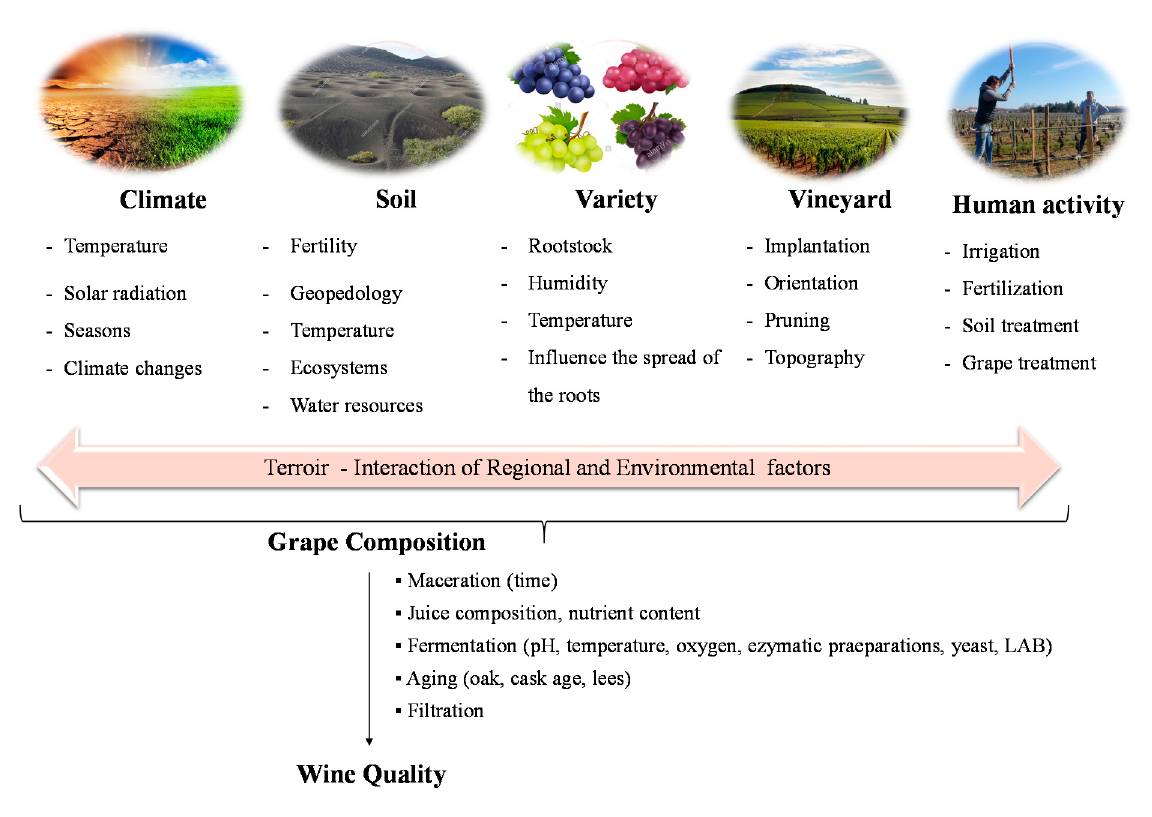
Figure 1. Most important influencing parameters on wine quality and